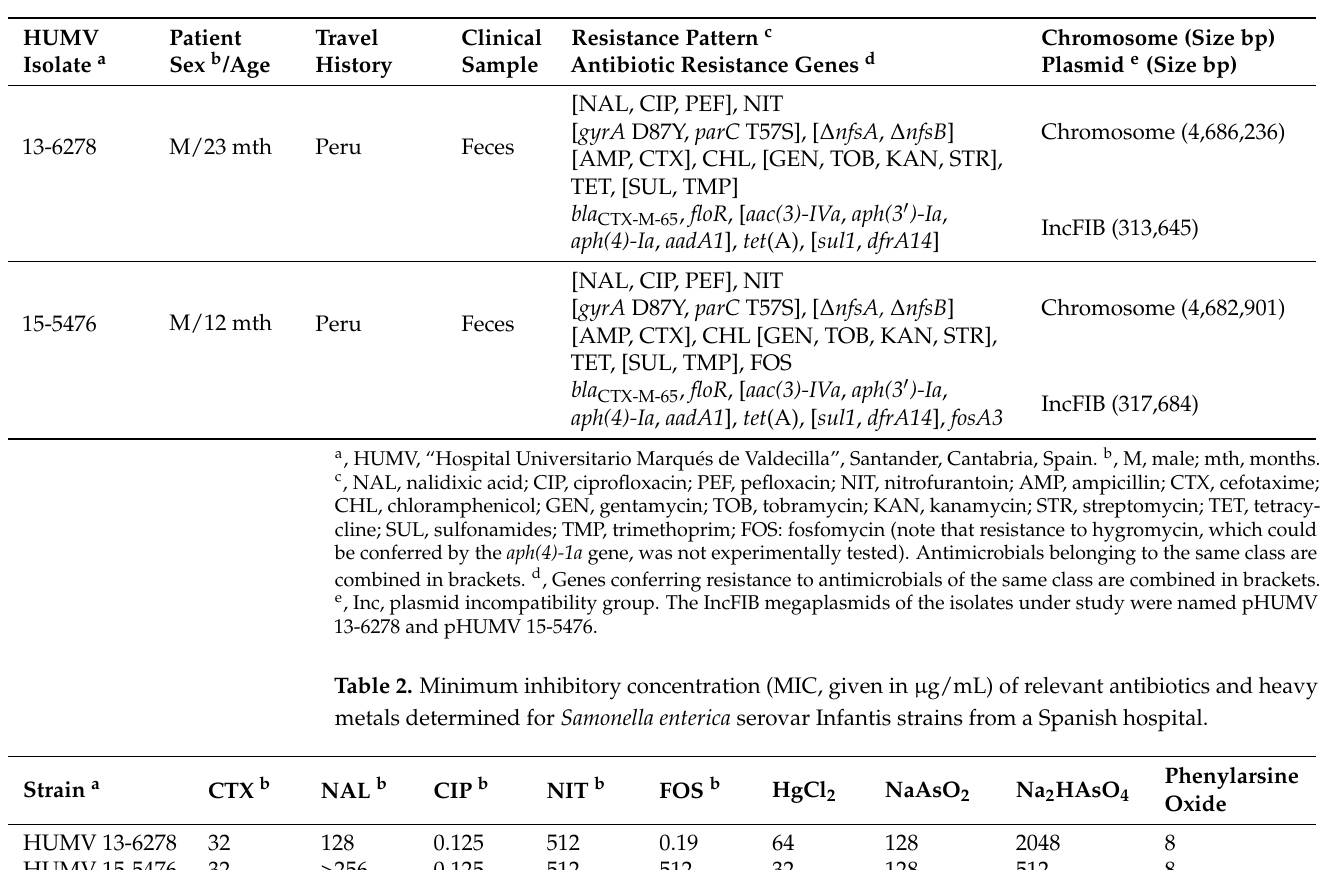
Table 1. Origin and properties of clinical cefotaxime-resistant isolates of Salmonella enterica serovar Infantis ST32.